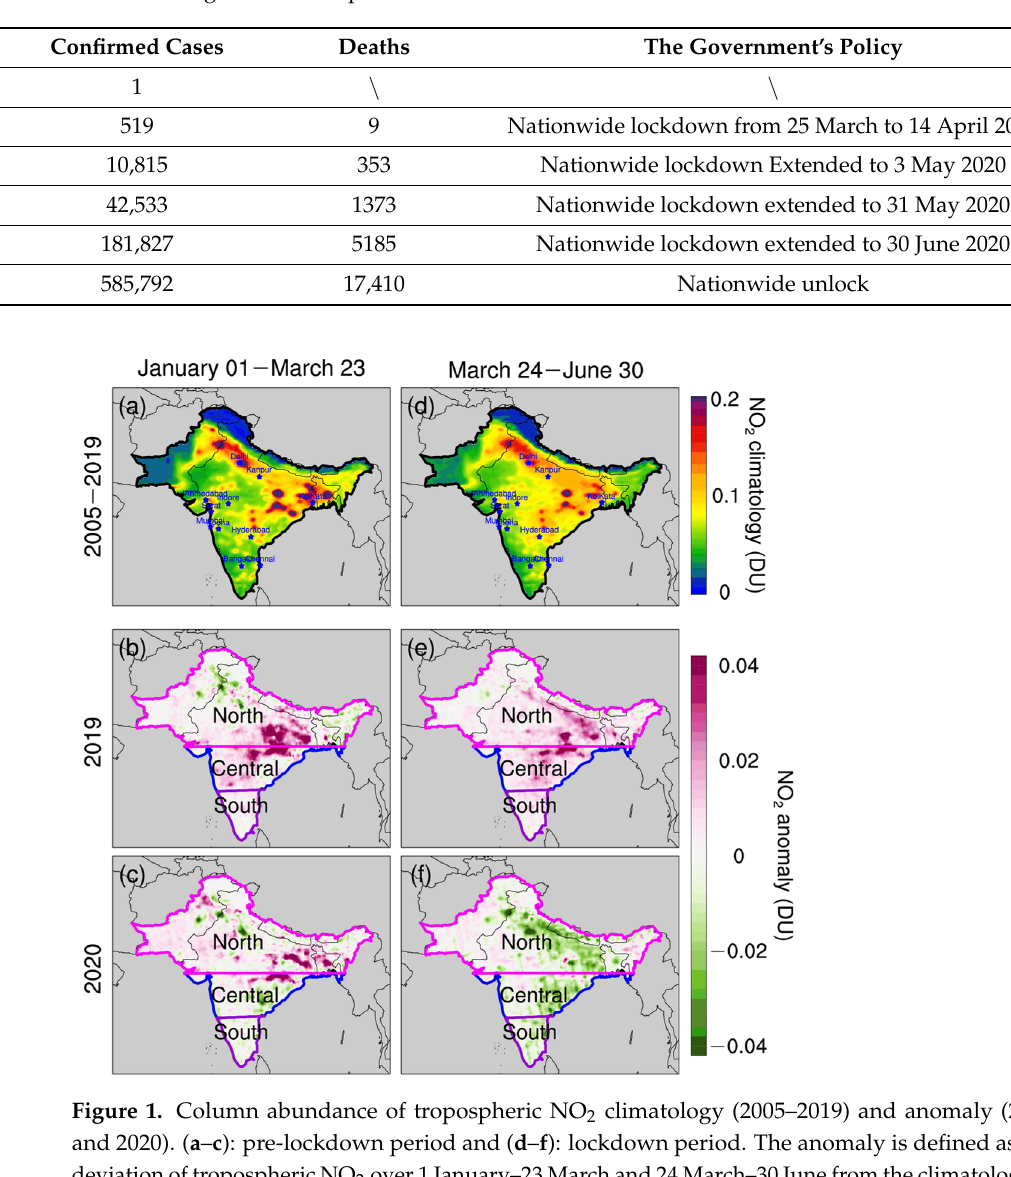
Table 1. The dates of key COVID-19 events in India, including confirmed cases, deaths, and imple- mentation of governmental policies.